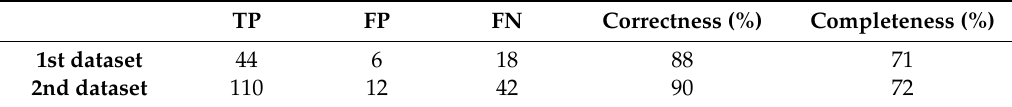
Table 3. Correctness and Completeness of Window Detection via DoN Method.